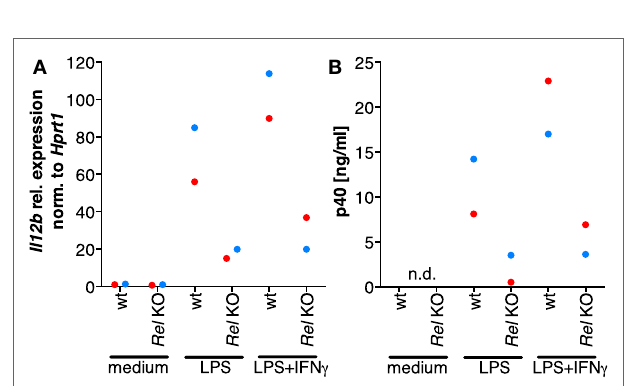
FigUre 6 | The role of Rel in the induction of Il12b expression. Murine Rel knockout BMDMs or wild-type BMDMs ( N = 2 each) were differentiated in vitro and stimulated with LPS or LPS and IFN γ for 24 h. Cells were used for RT-qPCR analysis of Il12b (a) , and Il-12p40 was measured in supernatants by ELISA (B) ; n.d., not detected.